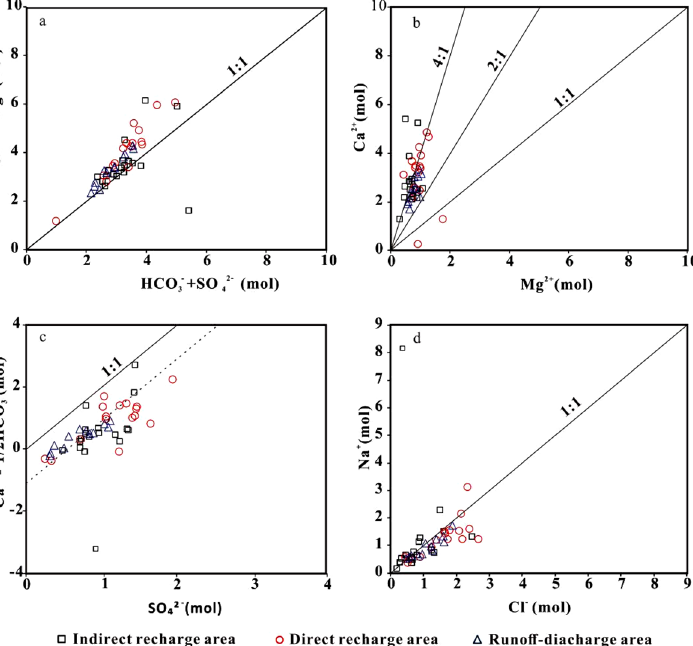
Figure 5. Ion ratio scatter map of karst water in Baotu karst spring system (( a ) (Ca 2+ + Mg 2+ ) vs (SO 42 − + HCO 3 ); ( b ) Ca 2+ vs Mg 2+ ; ( c ) Ca 2+ - 1/2HCO 3 − vs SO 42 − ; ( d ) Na + vs Cl − ).